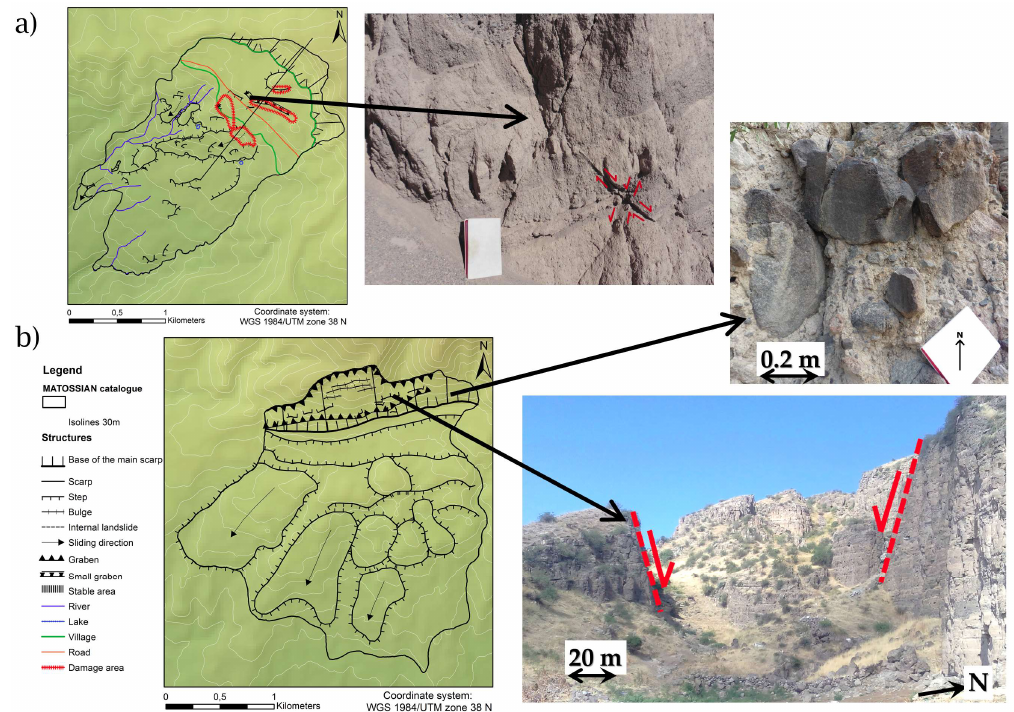
Figure 11. Indicators of brittle deformation during landslide movements that suggest possible seismic origins. ( a ) Morphological map of the Vokhjaberd landslide, indicating the location of outcrops presenting normal faulting related to gravitational movements. ( b ) Morphological map of the Garni landslide, indicating the graben structure below the main scarp (view towards the west, lower photograph) and of an outcrop along the main scarp presenting breccia and neatly cut pebbles (top photograph). Photographs taken on 15 September 2016.